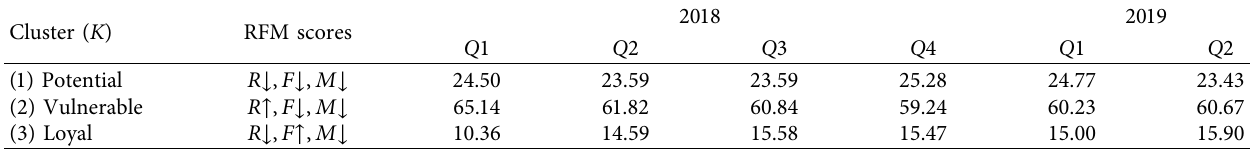
Table 15: Seasonal profiles of transit travellers in 2018 and 2019.